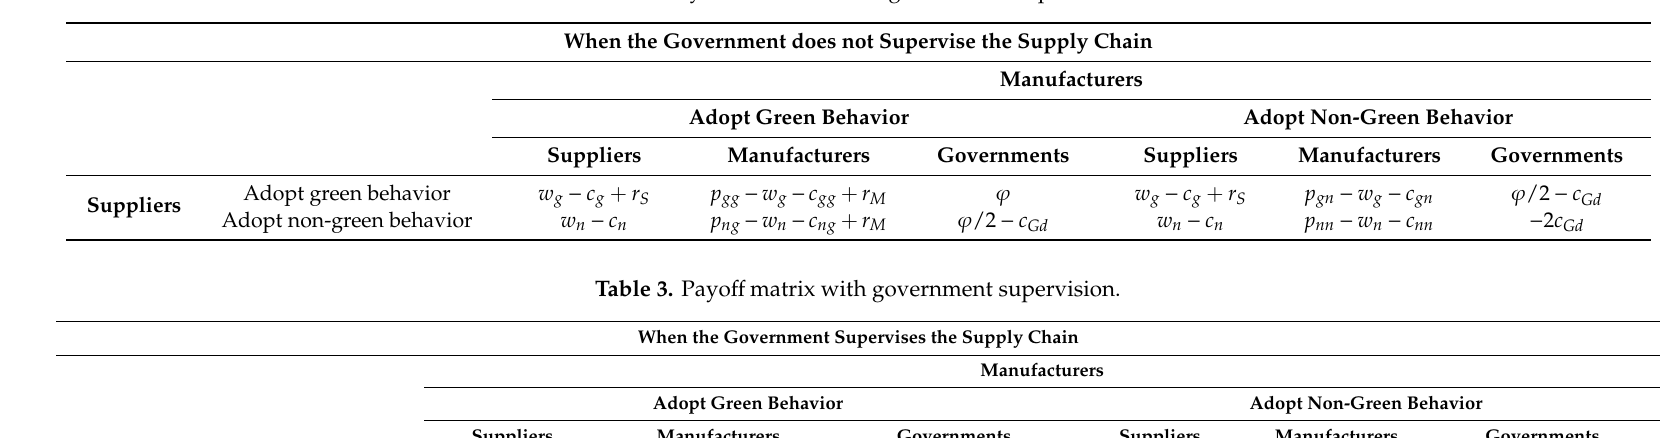
Table 2. Payo ff matrix without government supervision.